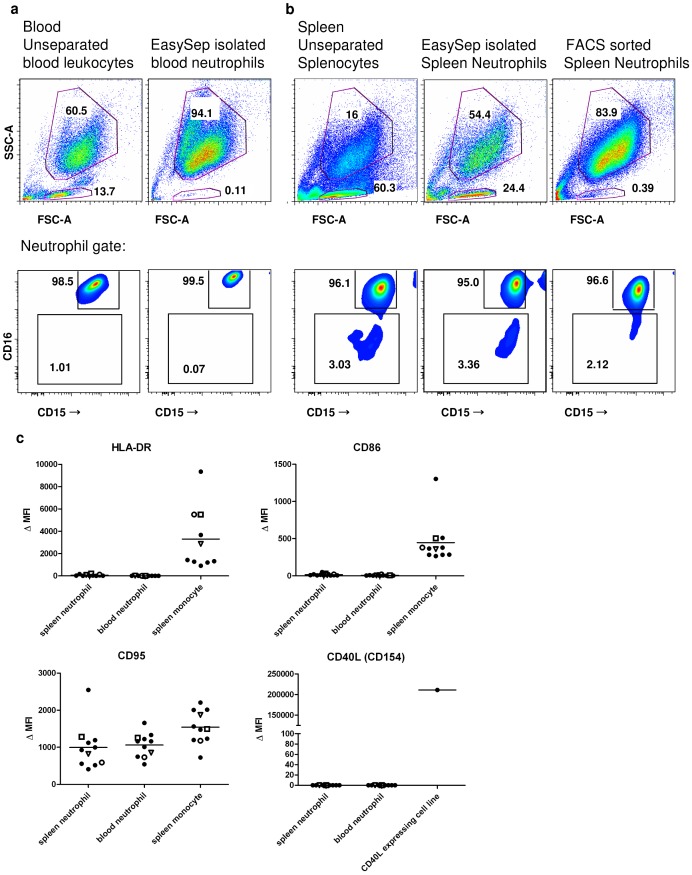
Expression pattern of splenic neutrophils does not differ from the expression pattern of circulating neutrophils.a,b: Upper panels: FSC/SSC pattern of blood (a) or spleen (b) for unseparated leukocyte/splenocyte suspensions, EasySep-isolated neutrophils, and FACS-sorted spleen neutrophils. Numbers indicate percentage of the total population. Lower panels: CD15/CD16 double staining of neutrophils as determined by canonical FSC/SSC. CD15: clone 28, FITC. CD16: clone 3G8, PE. Numbers indicate percentage of the neutrophil population. Data shown are of one spleen donor and one blood donor, and are representative of eight (unseparated), four (EasySep) or three (FACS sorted) independent experiments. c. Expression levels of HLA-DR, CD40L, CD86 and CD95 in neutrophils from unseparated leukocyte/splenocyte suspensions, as gated in a and b. Monocytes or a CD40L expressing cell line serve as positive control, gating strategy as in Figure S5a. Data summarize 11 independent experiments. In three of these experiments, the blood and spleen tissue were of the same donor, as indicated by the open symbols (n = 3). The MoAbs used are all commercially available, quality-tested antibodies (Table S3), with the same CD15 and CD16 clones as used by Puga et al
[10]. Δ MFI: median fluorescence intensity minus median fluorescence intensity of appropiate isotype control.